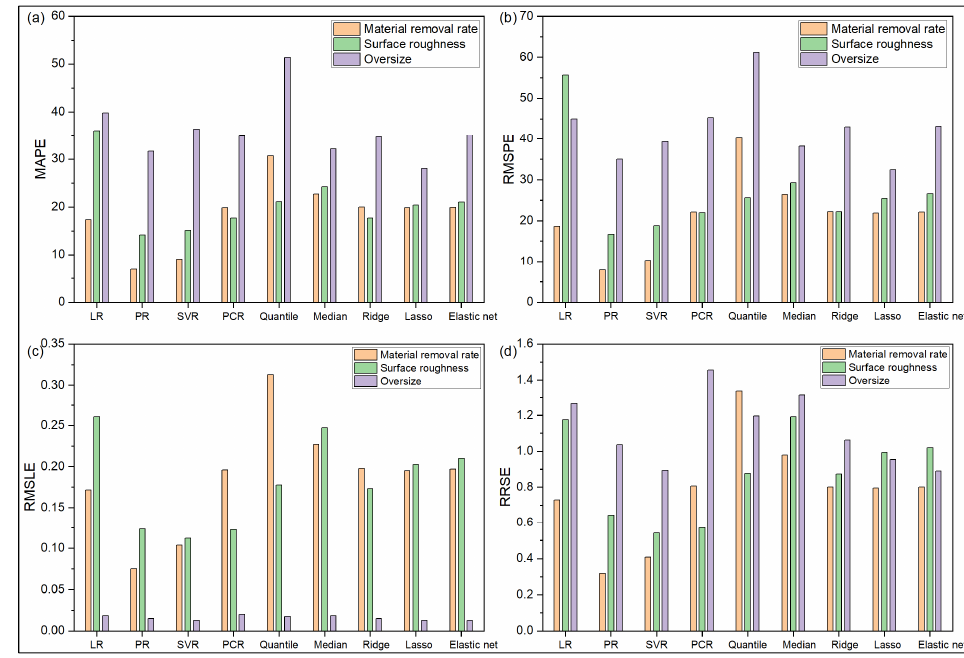
Figure 6. Predictive performance of various regression models for drilling operation. Prediction errors in terms of ( a ) MAPE ( b ) RMSPE ( c ) RMSLE ( d ) Table 9. Calculated p -values of Wilcoxon test for MRR in drilling.